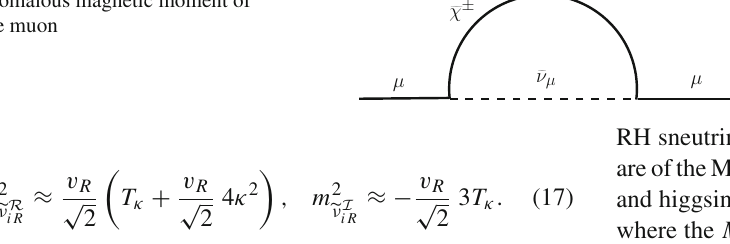
Fig. 2 Chargino-LH muon sneutrino (left) and neutralino-smuon (right) one-loop contributions to the anomalous magnetic moment of the